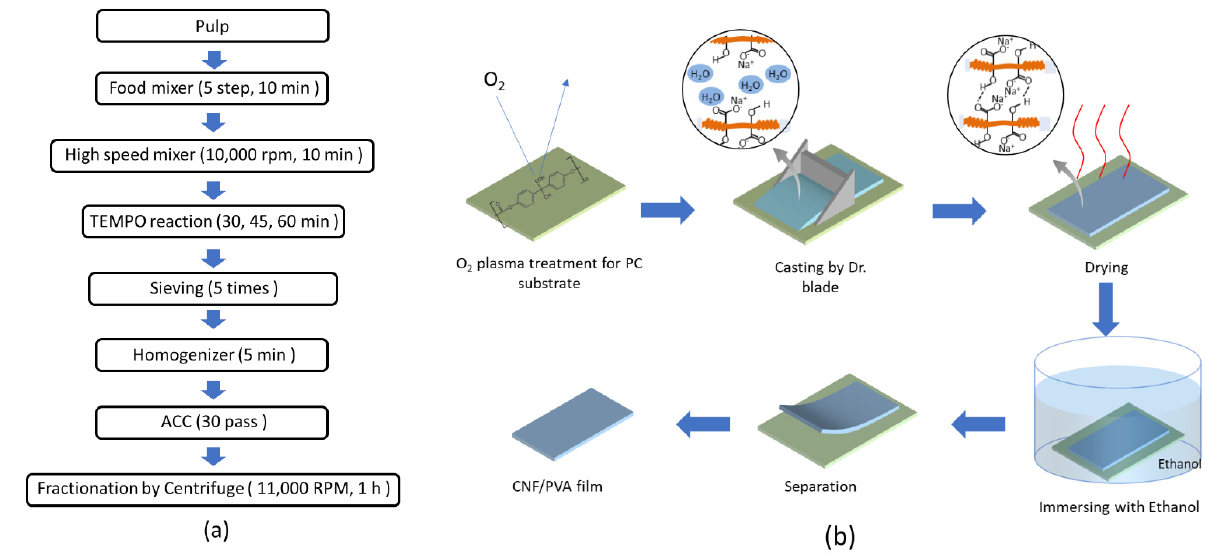
Figure 1. ( a ) The CNF isolation process made using TEMPO-oxidation and ACC methods; ( b ) CNF and CNF/PVA films fabrication process.